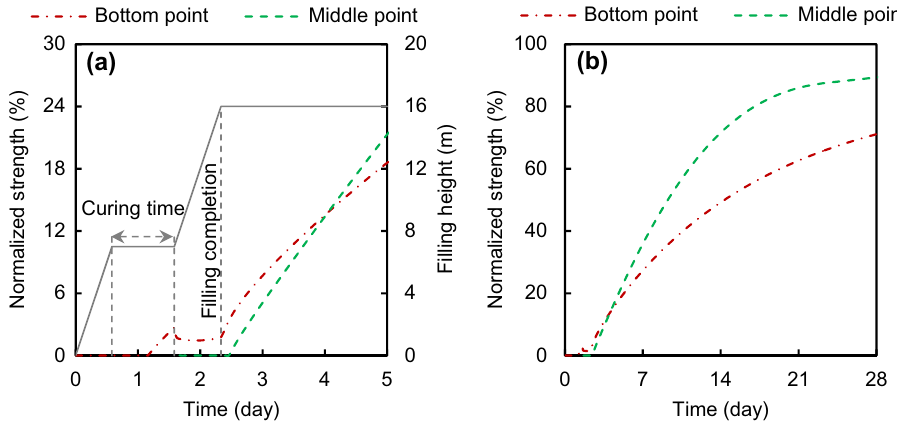
Fig. 17 Effect of fill height on PWP changes at bottom of CPB mass: a filling stage and b post-filling